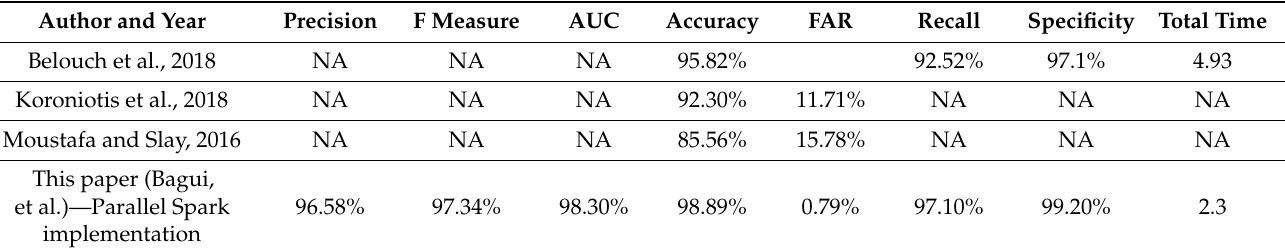
Table 4. Decision Tree Results on